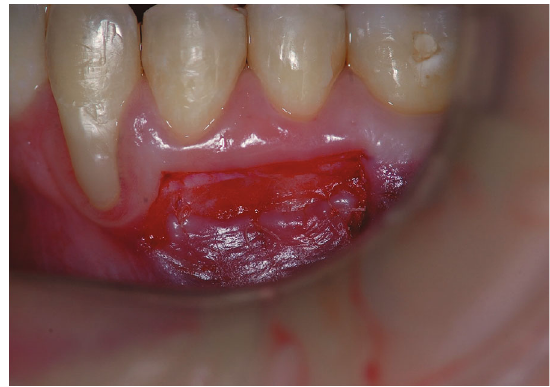
Figure 5: Next, two vertical incisions extending through the mucogingival line were made to connect to the horizontal incision. A split thickness was moved 3mm apically and sutured.